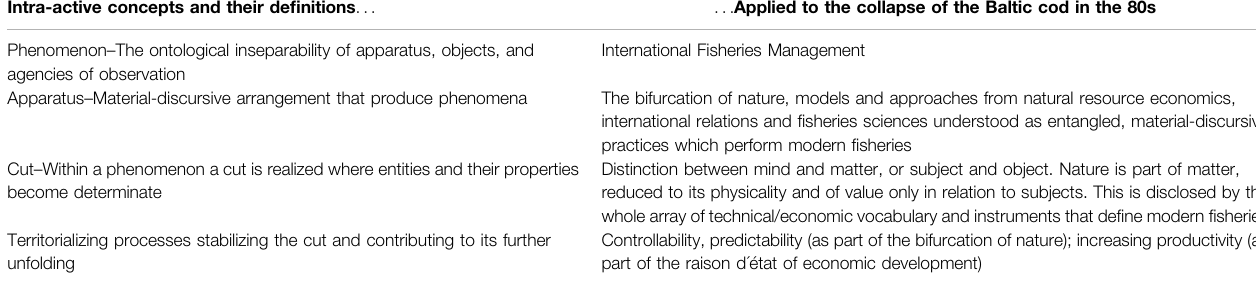
TABLE 1 | Intra-active concepts and their de fi nitions applied to the collapse of the Baltic cod in the 80s. Intra-active concepts and their de fi nitions